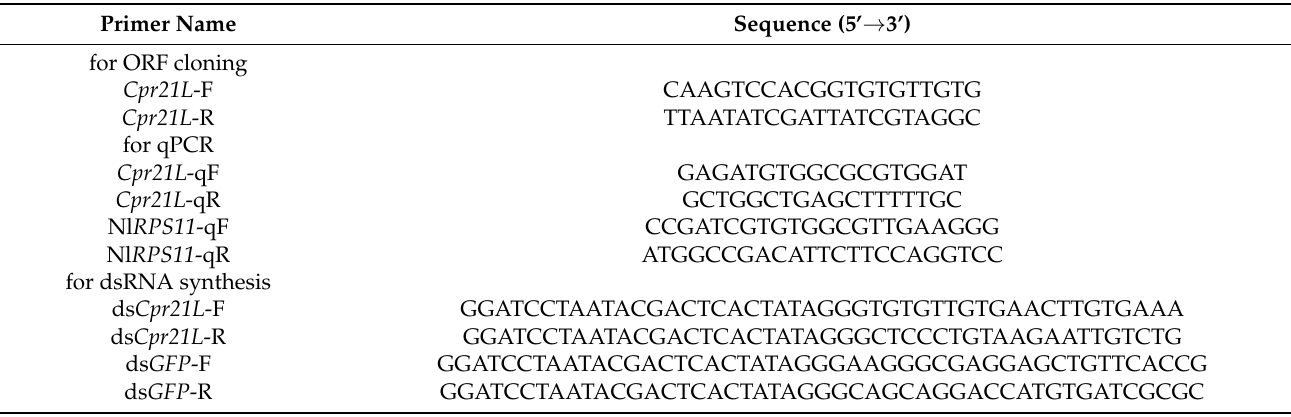
Table 1. List of primers used in this